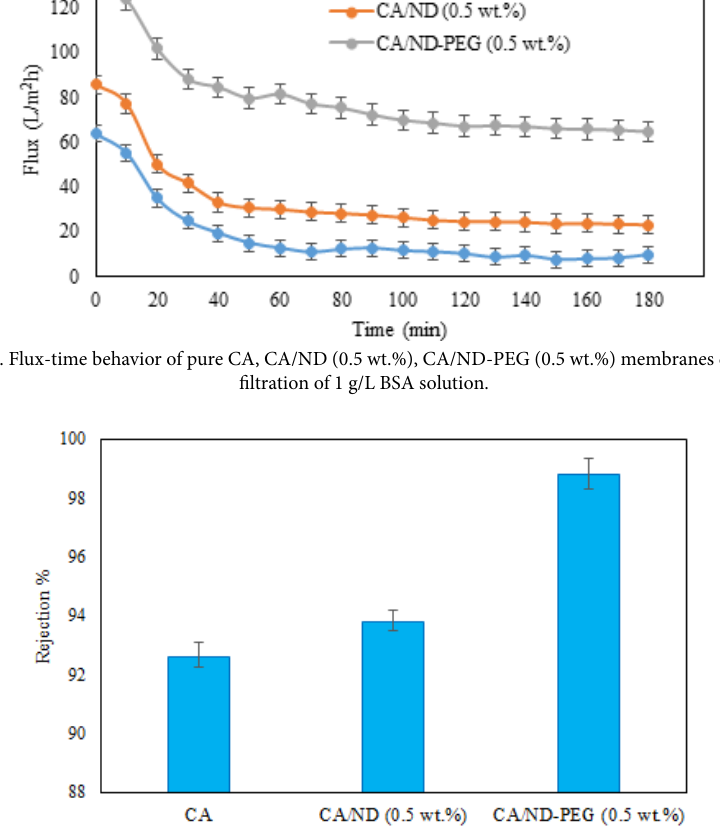
Fig. 9. Rejection performance of pure CA, CA/ND (0.5 wt.%), CA/ND-PEG (0.5 wt.%)